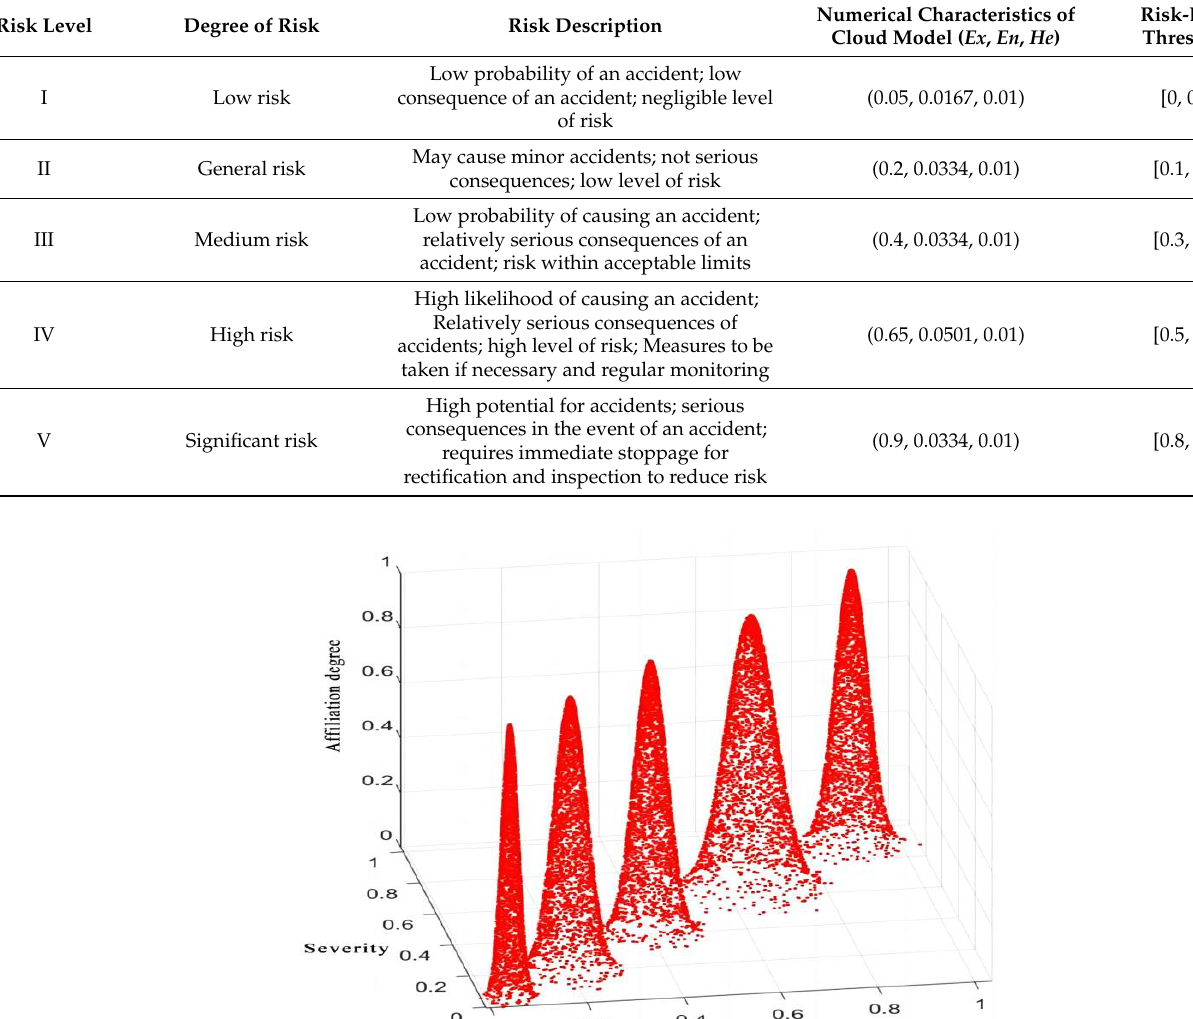
Table 6. LNG storage tank leakage accident risk level.